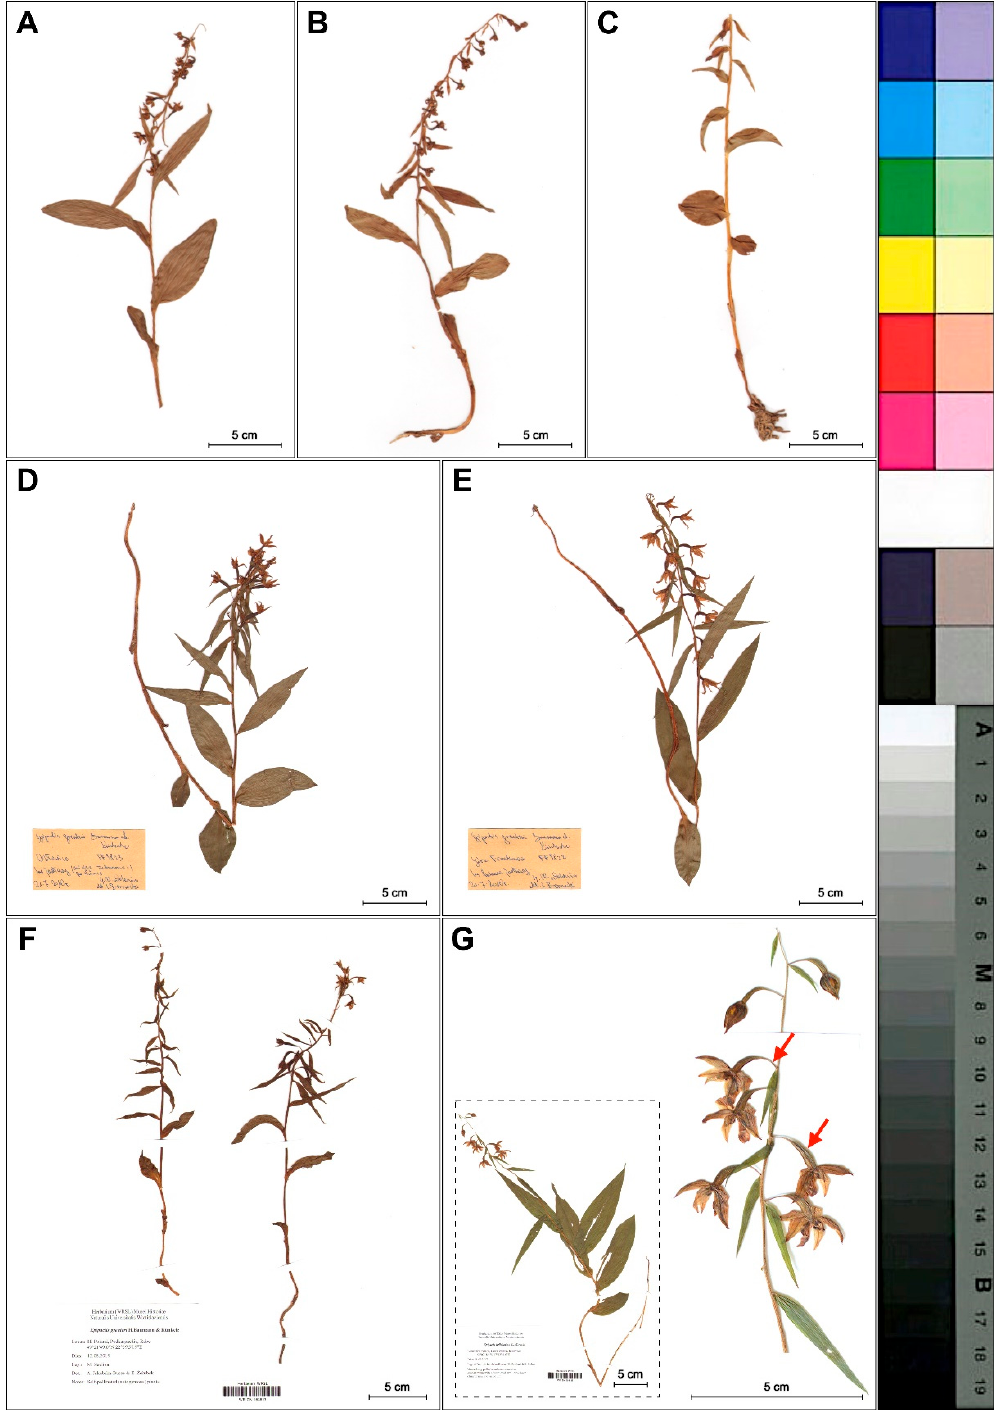
Figure 3. Differences in plant morphology of investigated Epipactis taxa. ( A–C ) Dry plants of E. greuteri from the Northeastern Carpathians, Semenic Mts., Romania. ( D–E ) Plants with viscidium in flower buds and well developed clinandrium identified by Bernacki as E. greuteri from the Przemyskie Foothills, SE Poland. ( D ) Cho ł owice near Krasiczyn and ( E ) Frankowa Mt. (Maciejówka). ( F ) E. greuteri from Rabe, Podkarpackie, SE Poland, (WR GN 064833). ( G ) E. helleborine from Kotowice (near Wroc ł aw), SW Poland, (WR SN 064835). The red arrows mark the longer pedicel, narrow ovary and pendant flowers (taxonomically significant features of E. greuteri ) presented in E. helleborine s. str.